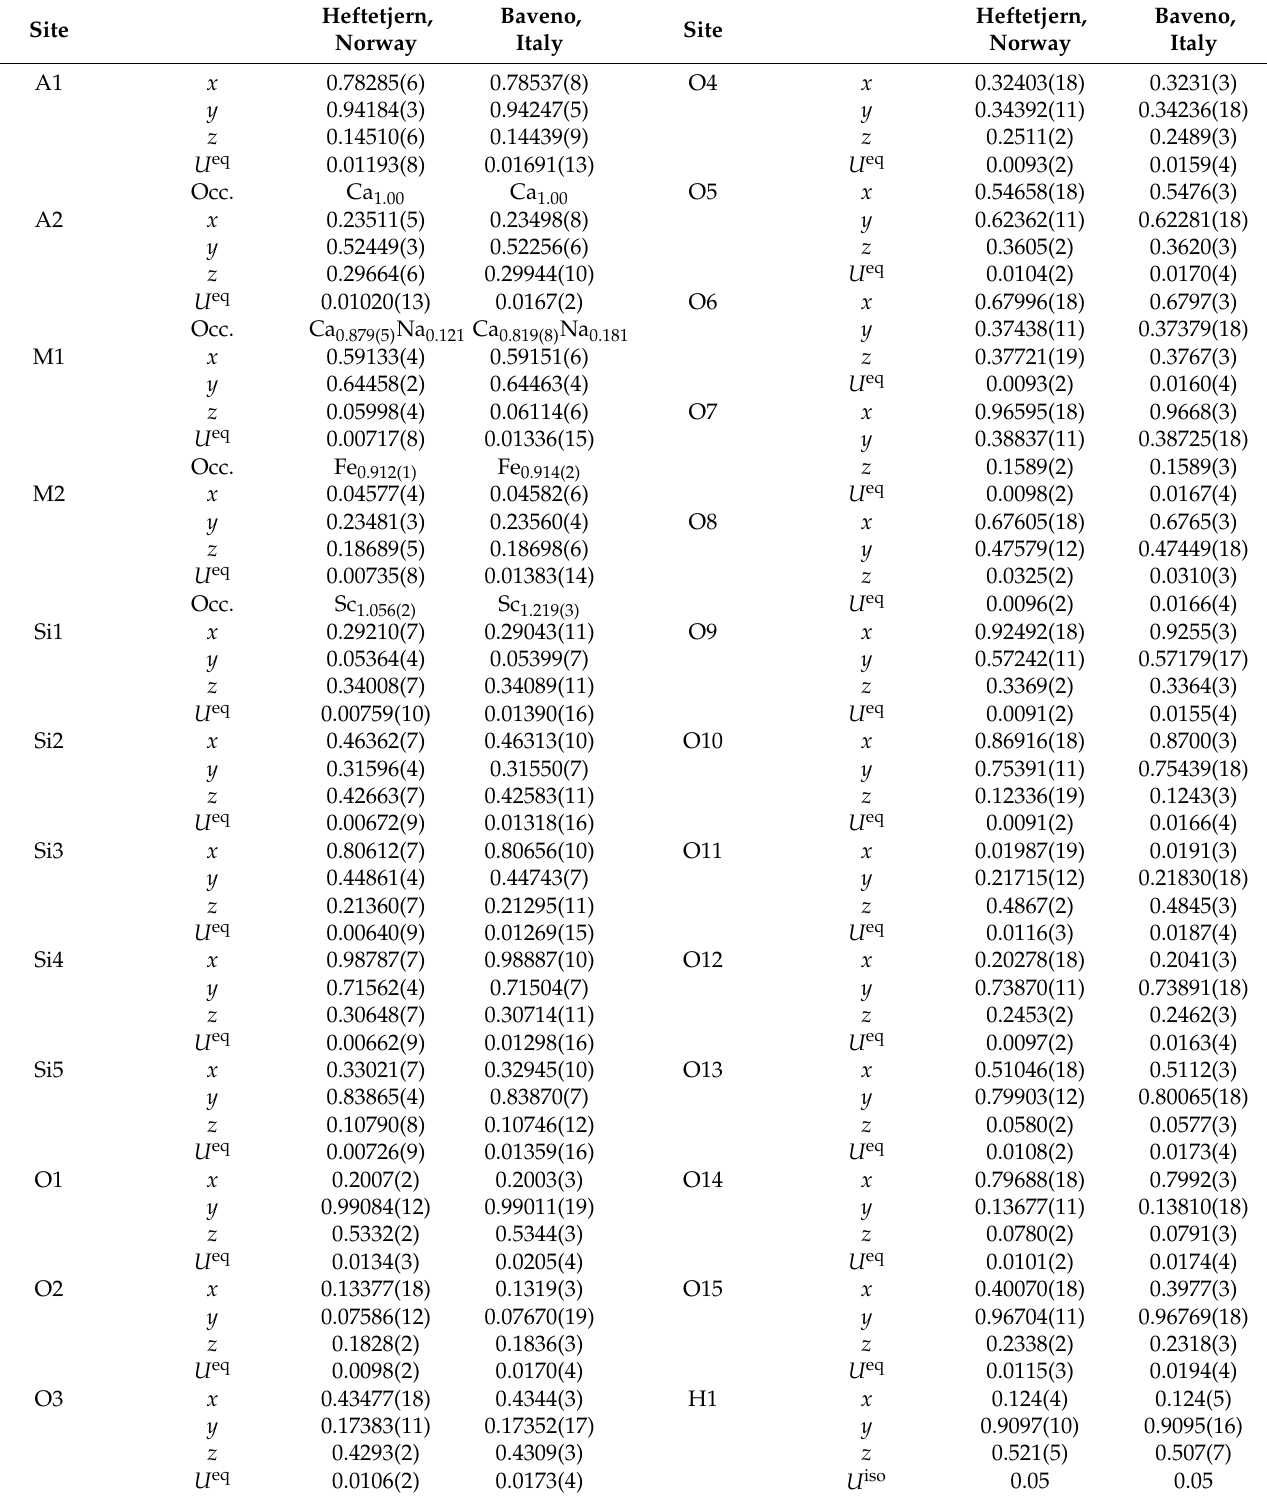
Table 3. Refined site occupancies at A and M sites, atomic positions and isotropic displacement parameters (Å 2